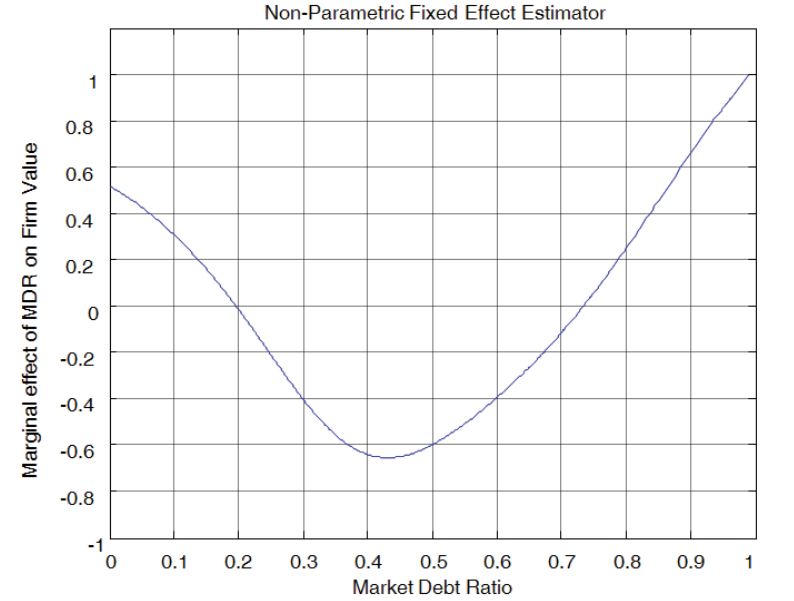
Fig. 2. Marginal effect of the MDR on FirmValue , as determined from the NFE model